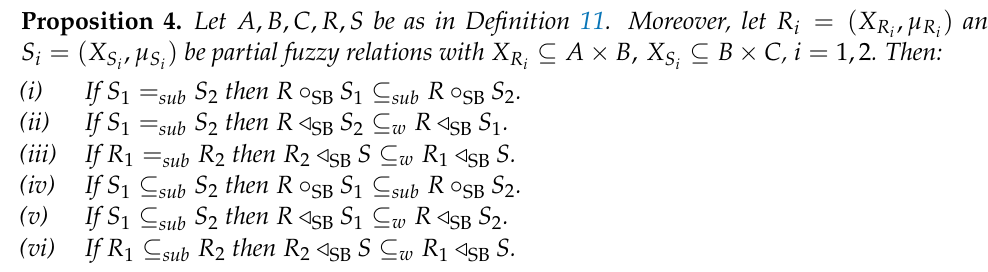
Figure 7. Examples of partial fuzzy compositions from Example